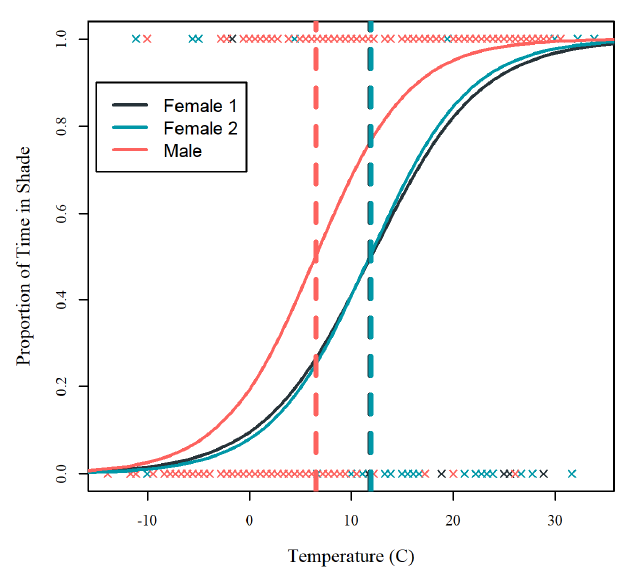
Figure 6. Logistic regression curves of shade use by temperature for three Sichuan takin. Observations with the proportion of shade greater than 0.5 or less than 0.5 were categorized as 1 or 0 for logistic analysis. Solid lines represent the individual logistic regression curves, dashed lines represent the 50%